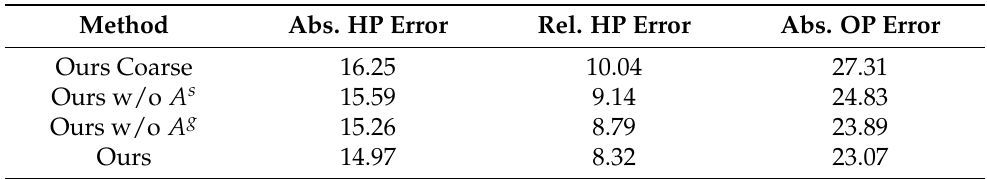
Table 3. Comparison of mean 3D distance error (mm) when using InterGCN without general relation graph A g or interaction-specific relation graph A s on